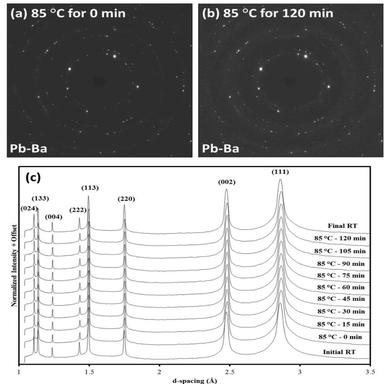
Full Debye-Scherrer rings of the Pb-Ba foil at 85 ◦C at (a) 0 and (b) 120 min (c) Integrated 1-D diffraction patterns from a Pb-Ba foil during isothermal holding at 85 ◦C, where only patterns at every 15 min interval are shown.